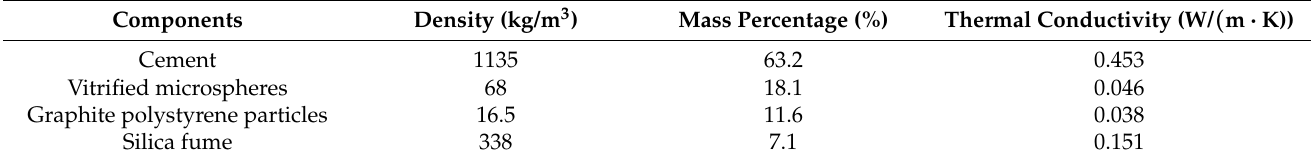
Table 1. The constituents of the GCIB.